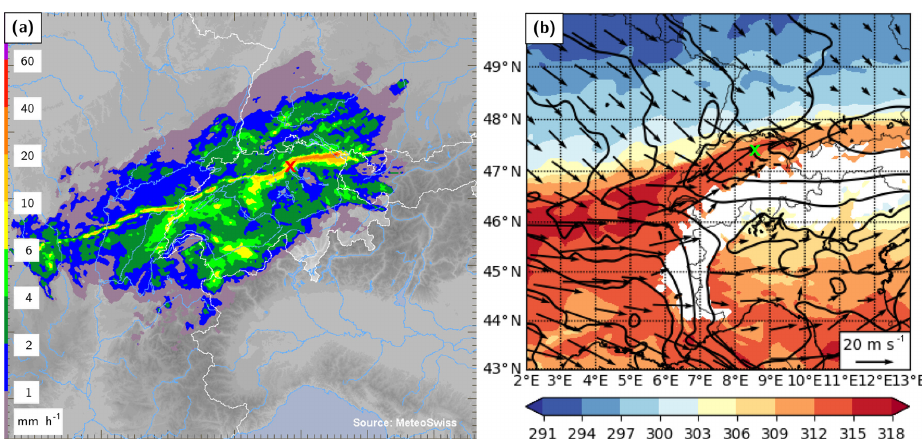
Figure 1. (a) Radar composite of surface rain intensity from MeteoSwiss at 19:00UTC 20 November 2015, when the surface front passed over the measurement site. (b) Equivalent potential temperature ( θ e in K, colour) and horizontal wind (arrows) at 850hPa from COSMO- 2 analysis data at 19:00UTC 20 November 2015. The location of the measurement site at Zurich is indicated by a red and green cross,